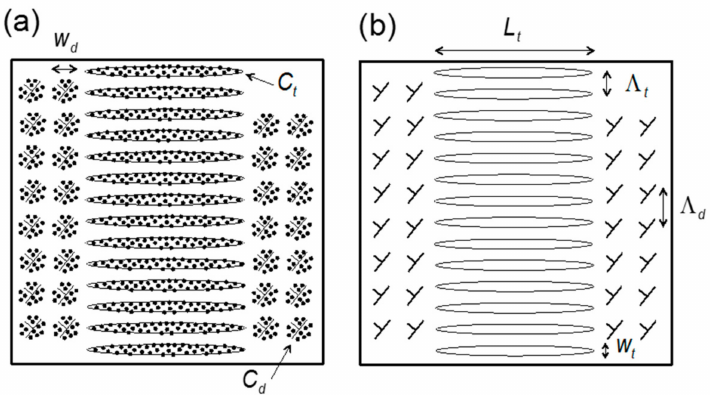
Figure 6. Schematic representation of ( a ) inhomogeneous carbon distribution in a martensite plate in as-quenched conditions and ( b ) its resulting microstructural